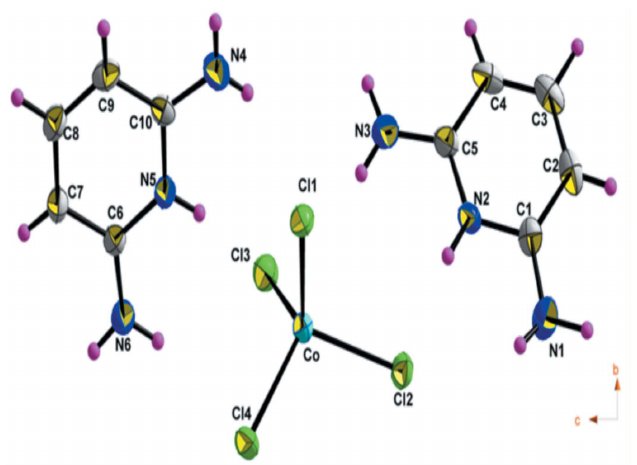
Figure 1 The asymmetric unit of (I), with displacement ellipsoids are drawn at the 30% probability